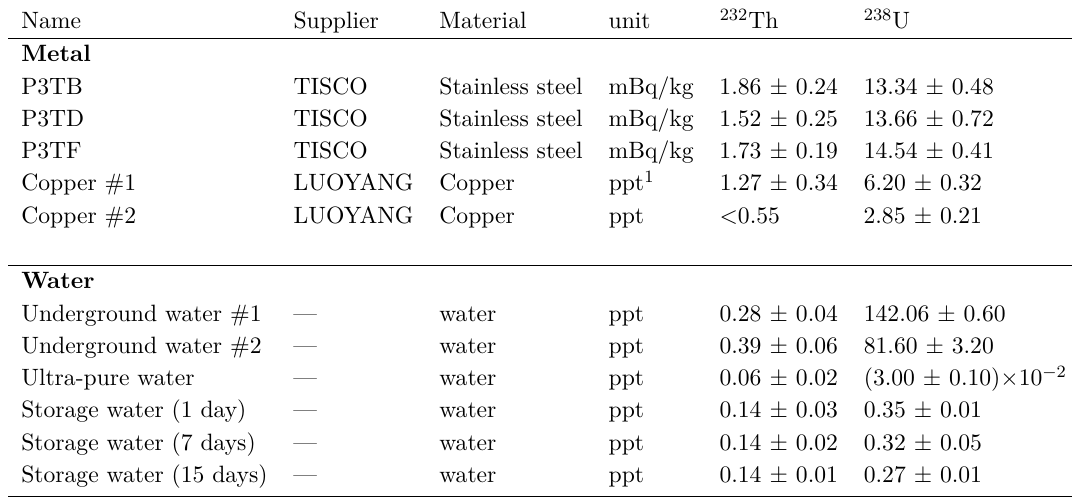
Table 4. ICP-MS measurement results (upper limit with 90% C.L. is